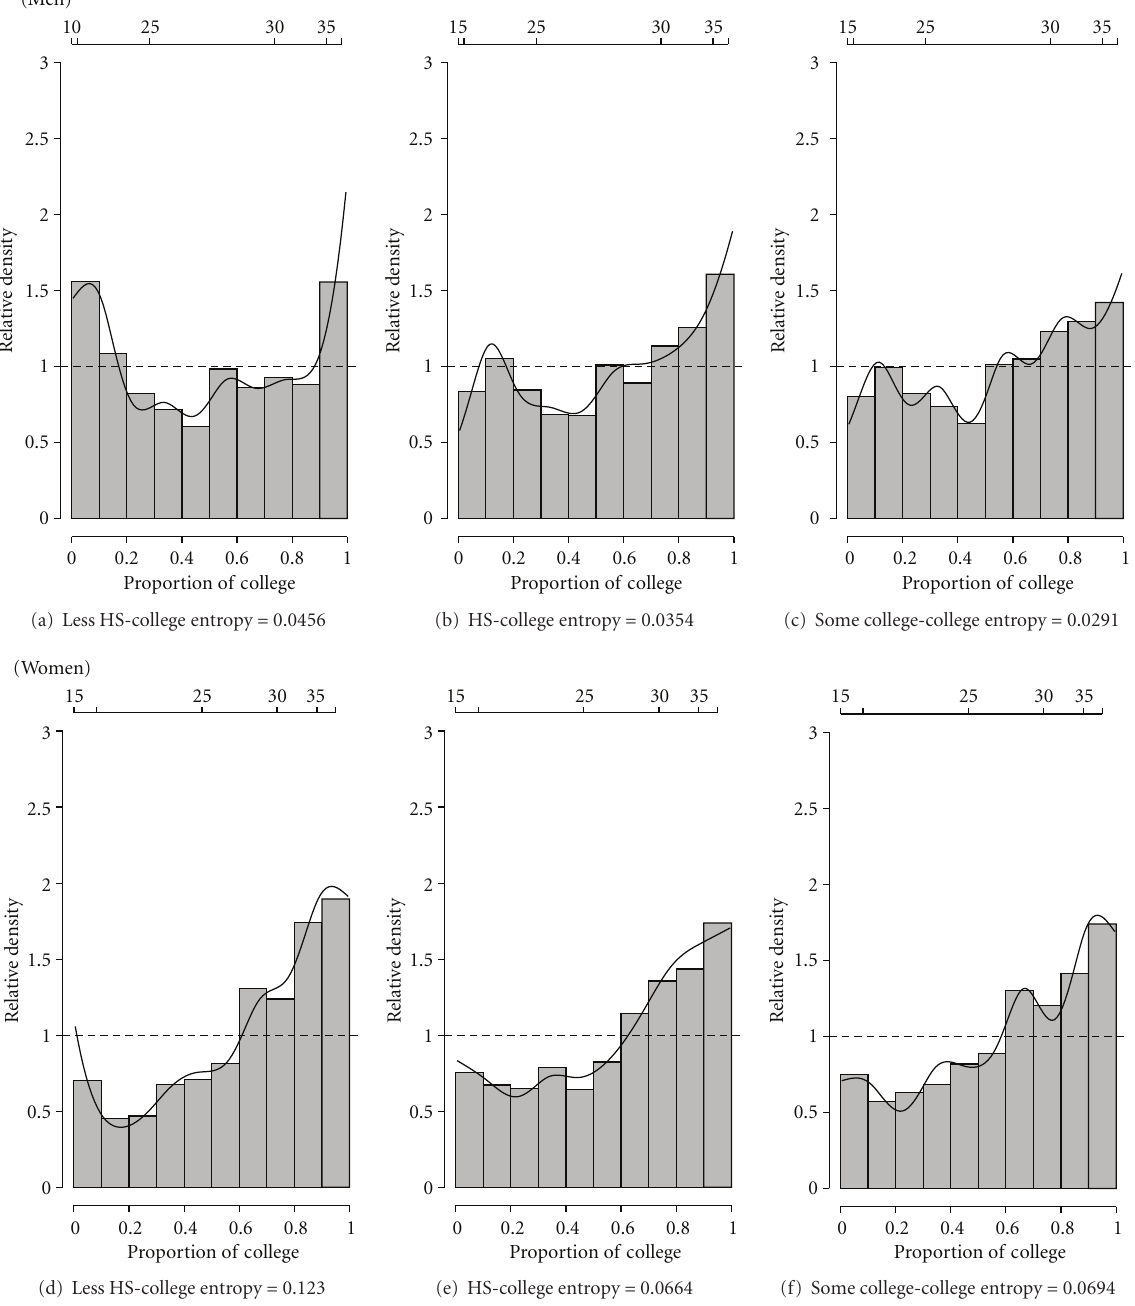
Figure 3: Age-adjusted relative body mass index distributions (1999–2006) between men (top) and women (bottom) by those with a college degree or more compared to (a,d) those with less than a high school diploma; (b,e) those with a high school diploma or GED; (c,f) those with some college education. Deciles chart superimposed on relative densities. Data from the National Health and Nutrition Examination